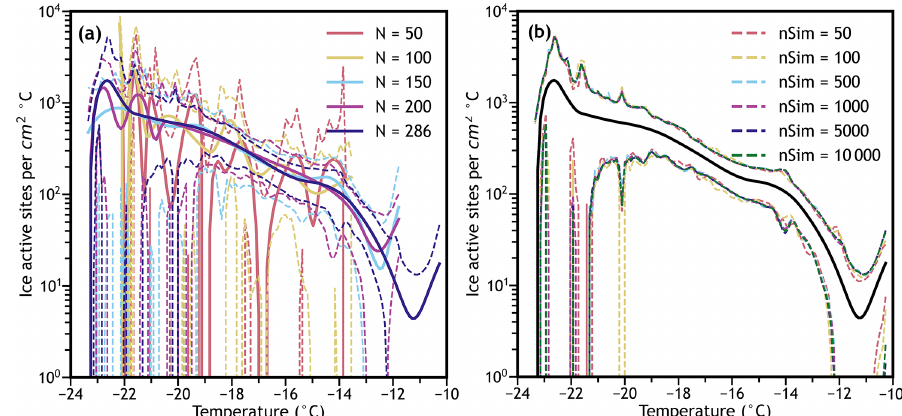
Figure 5. Differential freezing spectra of the water aged FUE ash with tskew confidence bands (a) calculated with varying numbers of data points randomly sampled without replacement from all six experiments with 1000 bootstrapping simulations, and (b) calculated using different numbers of bootstrapping simulations, with the experimental combined spectrum shown in black. Figure S4 shows the cumulative spectra, but the effects of sample size are not as